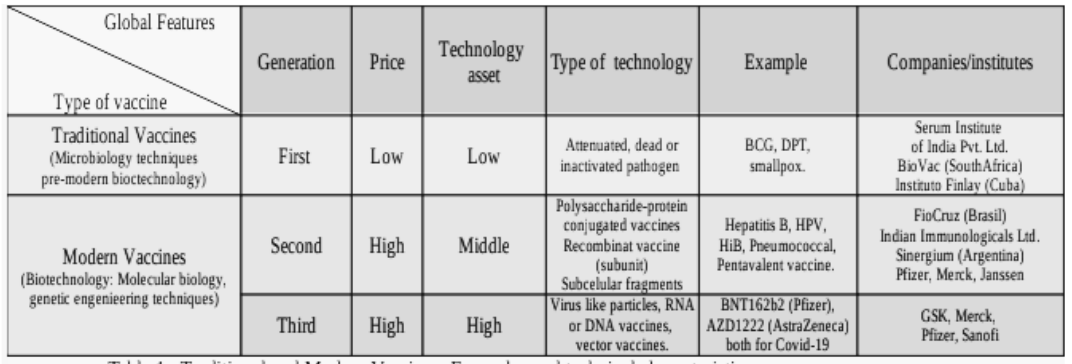
Table 1: Elaborated by the authors based on Folegatti et al. 2020 and Mulligan et al.